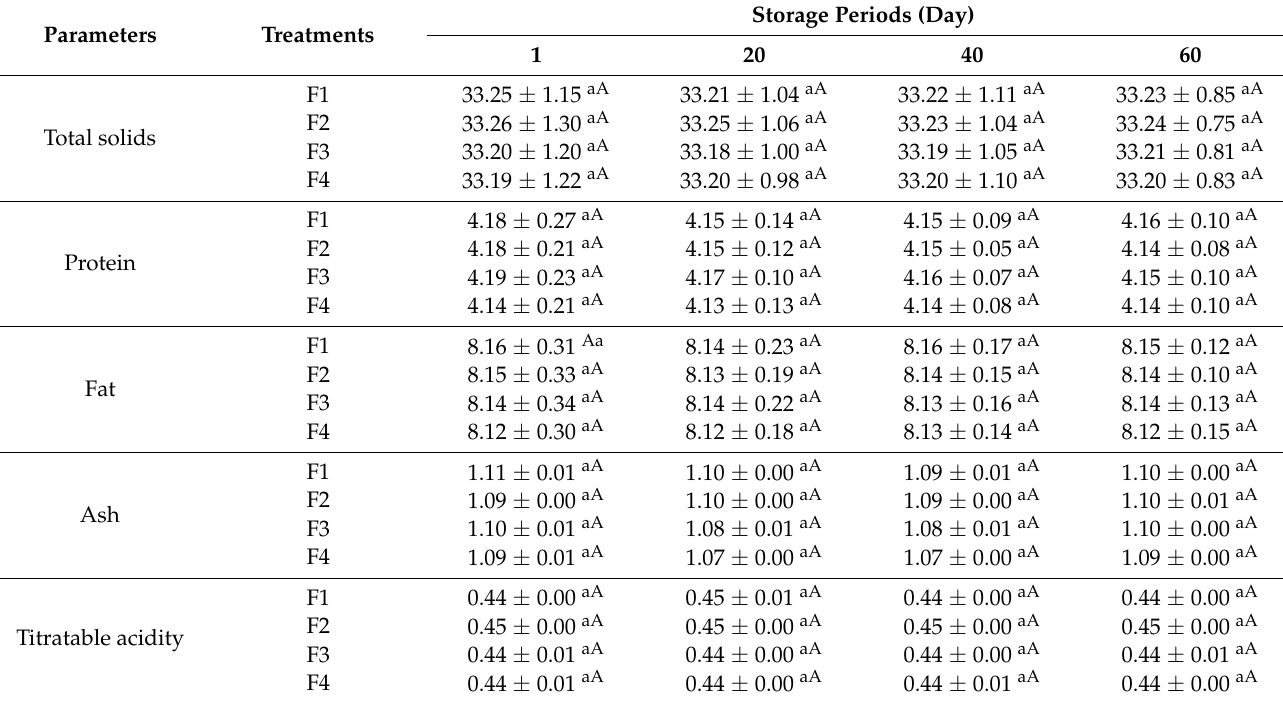
F1: Control frozen yogurt; F2: Frozen yogurt with stevia; F3: Frozen yogurt with sucralose; F4: Frozen yogurt with sorbitol; a : Means in the same column with different small letter superscripts are significantly different ( p < 0.05); A : Means in the same row with different small letter superscripts are significantly different ( p <